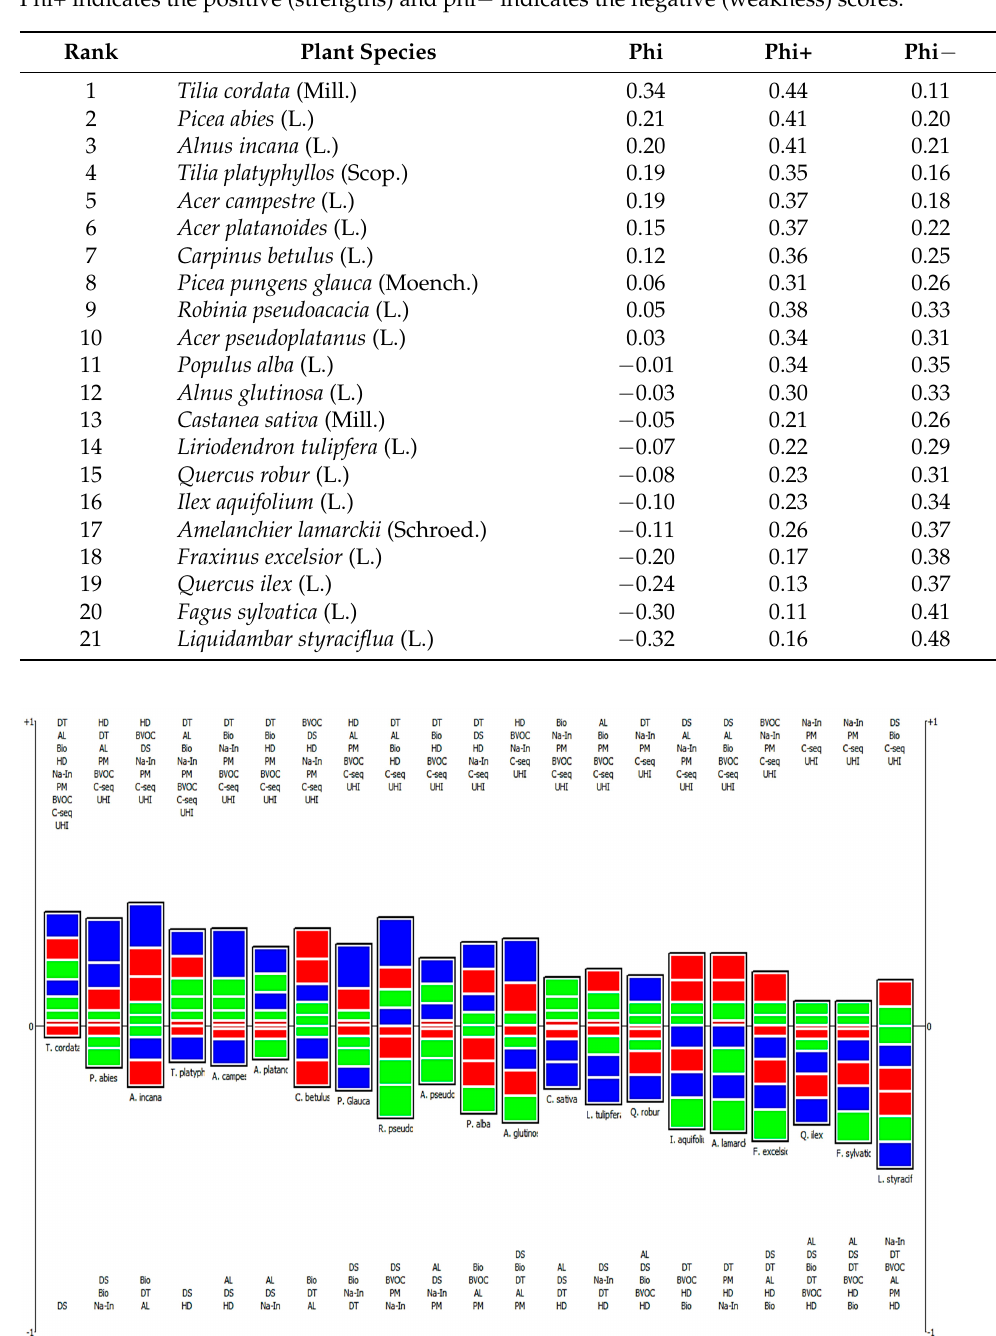
Figure 5. The PROMETHEE rainbow diagram illustrating a disaggregated view of the PROMETHEE II complete ranking of the investigated plant species for the criteria: hardiness (HD) and drought tolerance (DT) illustrated in blue slices; allergenicity (AL), BVOC emissions (BVOC), and disease susceptibility (DS) illustrated in red slices; and biodiversity (Bio), native-invasive (Na-In), PM mitigation (PM), net carbon sequestration (C-seq), and reduce urban heat island effect (UHI) illustrated in green slices. The upward slices on the phi scale correspond to the criteria contributing positively (+1) while the downward slices correspond to the criteria contributing negatively ( − 1). (For an interpretation of the references to color in this figure legend, the reader is referred to the web version of this article.)